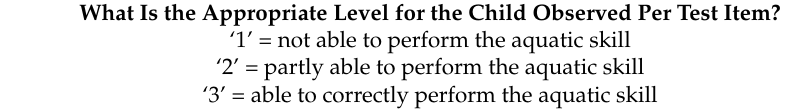
Table 1. Rater’s score sheet